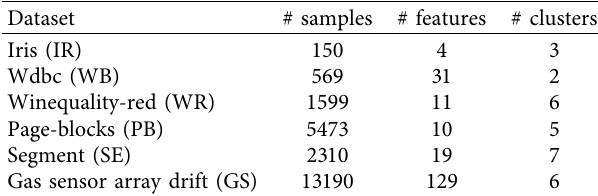
Table 1: Details of six